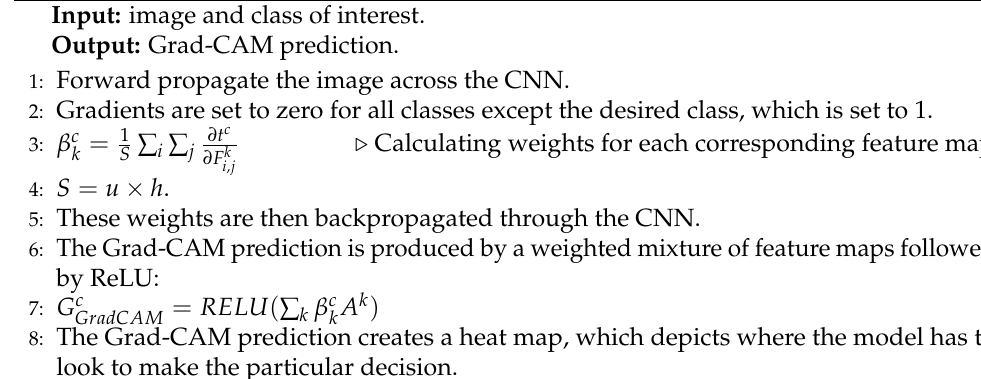
Figure 7. ( a ) Grad-CAM results on partially trained ResNet18. ( b ) Semantic predictions of partially trained ResNet-18. Algorithm 2 Algorithm for the generation of Grad-CAM predictions